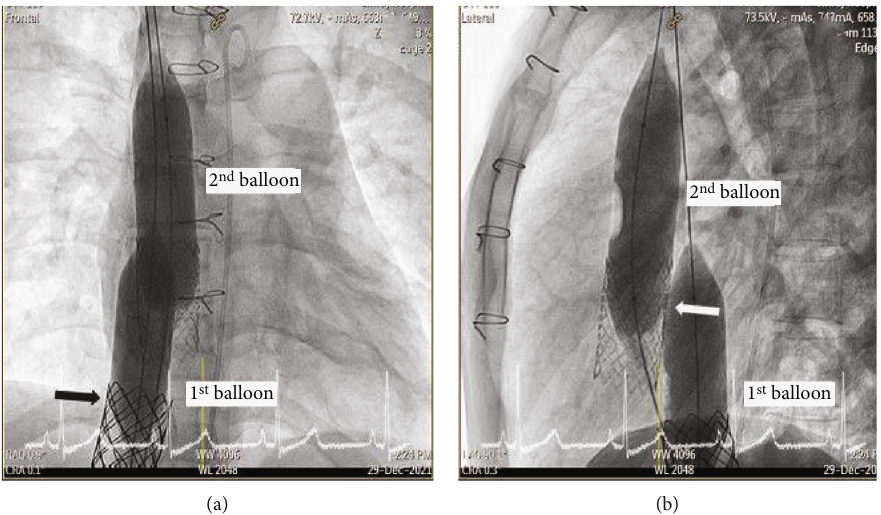
Figure 13: The balloon inside the covered stent was in fl ated in an attempt to pull down and reposition the embolized covered stent, but that attempt was unsuccessful. We then deployed another 24 mm × 40 mm Z-Med balloon in an attempt to use an external force to squeeze or pushing the embolized covered stent to a smaller diameter to be able to pull back inside fi rst stent, but that was also unsuccessful due to the strong radial force of the covered graft (a, b). The black arrow and white arrow indicate the position of the bare stent and the covered stent,